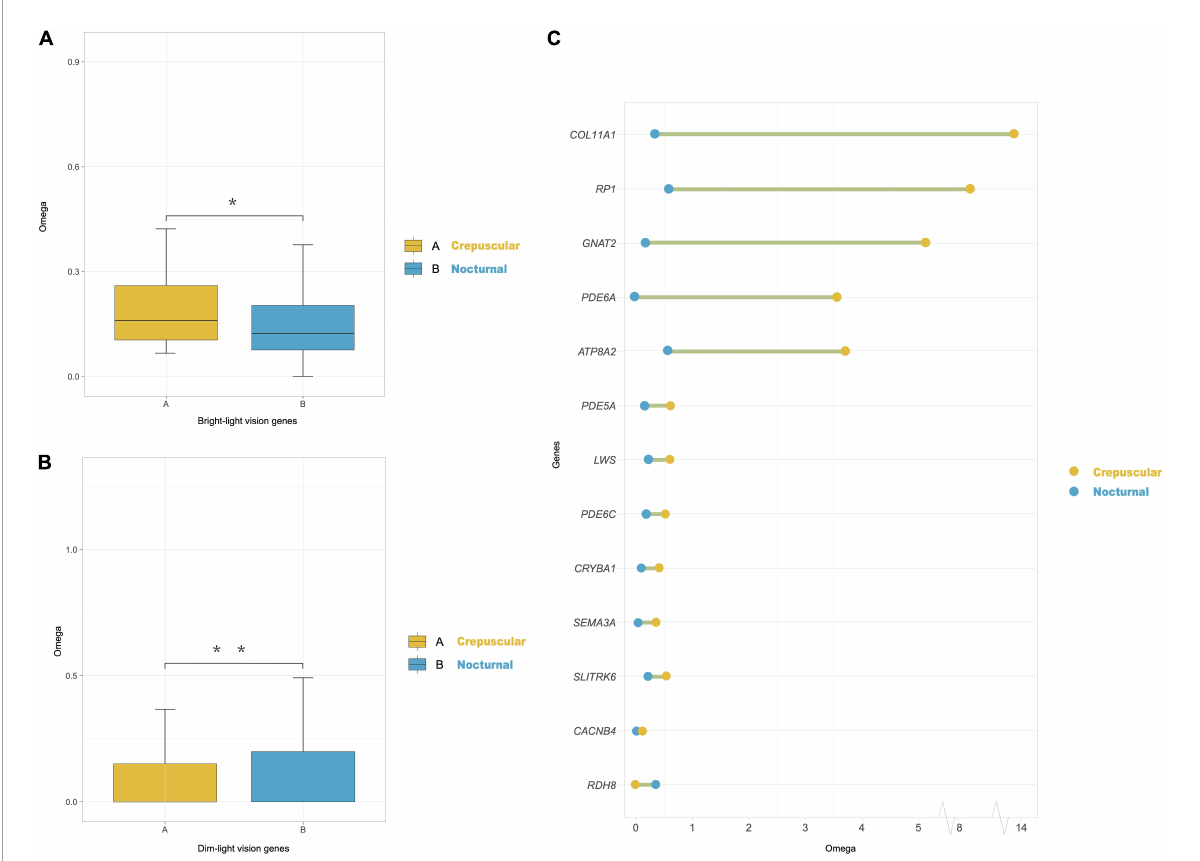
FIGURE3 Divergently selected genes in marsupials with different activity patterns. (A) Omega ( d N / d S ) ratios of cone phototransduction pathway genes (i.e., bright-light vision genes) of crepuscular and nocturnal marsupial lineages obtained using the PAML free-ratios model. We compared each pair of groups by the Wilcoxon test (* P < 0.05). (B) Omega ( d N / d S ) ratios of rod phototransduction pathway genes (i.e., dim-light vision genes) of crepuscular and nocturnal marsupials. We compared each pair of groups by the Wilcoxon test (** P < 0.01). (C) Overview of a shift in selection pressure on vision genes between crepuscular and nocturnal marsupials using PAML clade model C. Blue dots indicate the omega ratio of background nocturnal species, and yellow dots represent the omega ratio of crepuscular Macropus species. A green line between the two dots indicates a significant P- value (LRT, P <